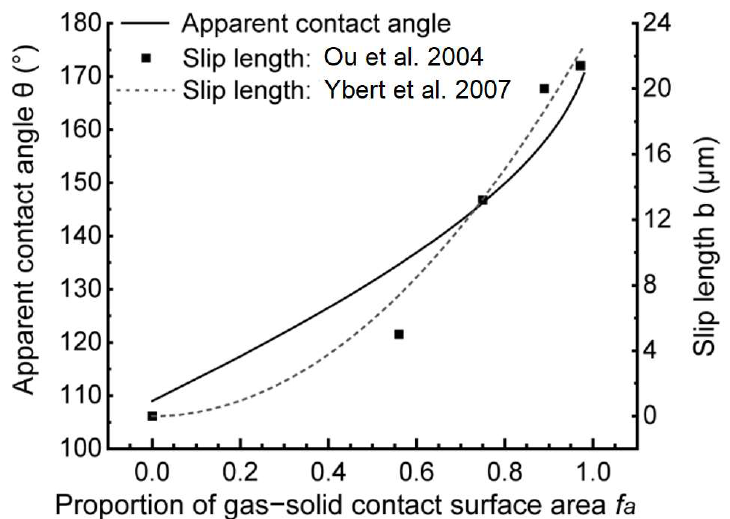
Figure 3. Relationship between apparent contact angle, slip length, and proportion of gas–solid contact surface area